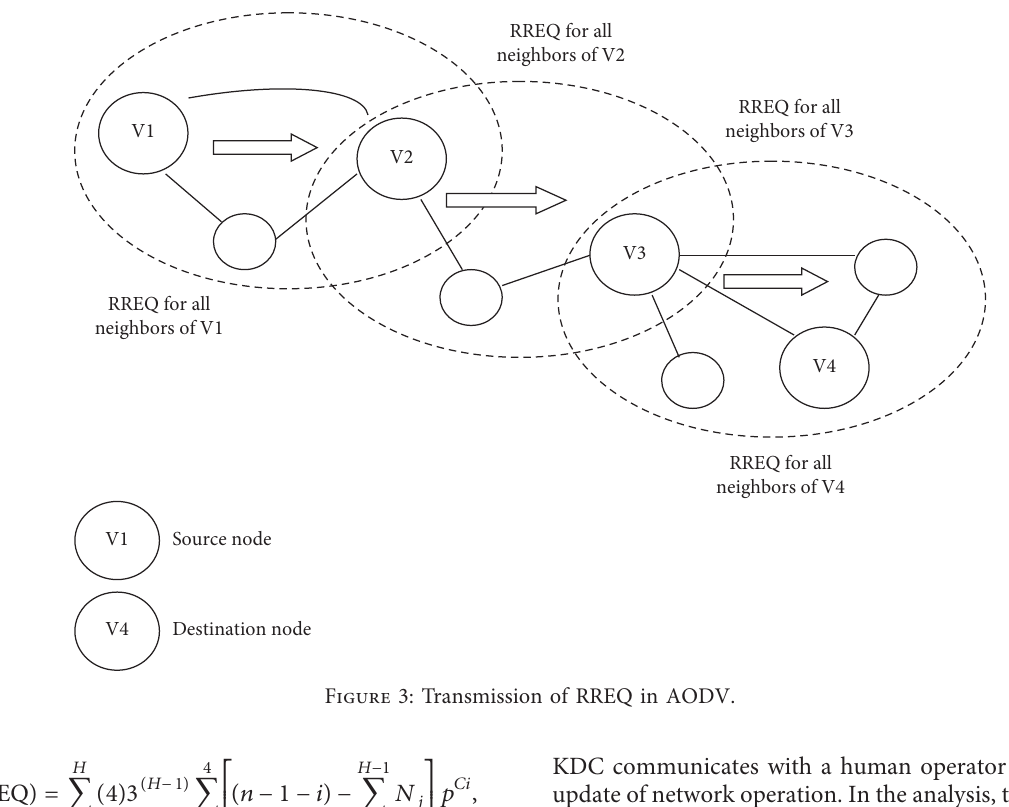
Figure 3: Transmission of RREQ in